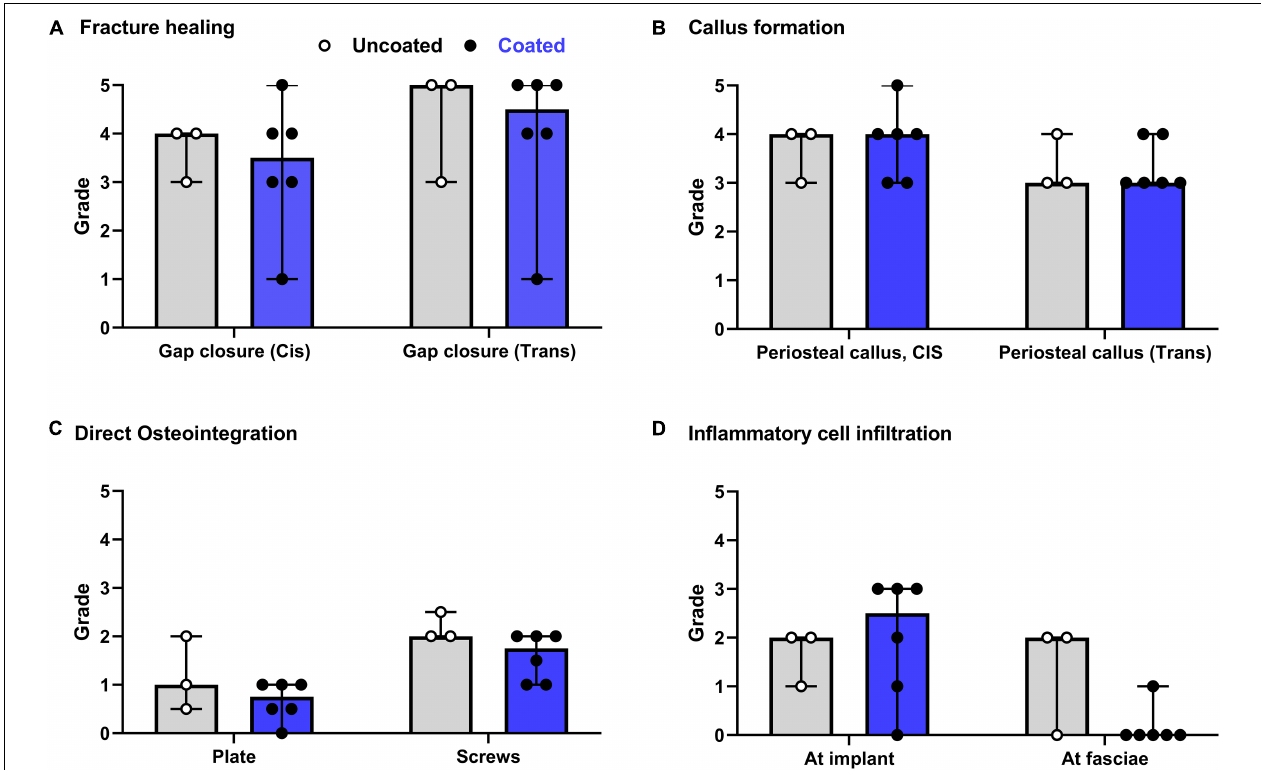
FIGURE 4 | Overview of histological evaluation of rabbits receiving coated and uncoated screws. (A) Fracture healing; (B) callus formation; (C) direct osteointegration; (D) inflammatory cell infiltration. Rabbits were euthanized 8 weeks after osteotomy and fixation with uncoated (gray bars [median/group], white dots [individual values]) or coated (blue bars, black dots) LCPs and screws. The entire operated bone was fixed, embedded in polymethylmethacrylate (PMMA), sectioned and stained with Giemsa Eosin. Semi-quantitative histological scores (0–5) were given by a blinded veterinary pathologist for a group of n = 6 rabbits receiving coated implants and n = 3 rabbits receiving uncoated implants. Features were scored for the entire section. Error bars represent the range. No statistical comparisons